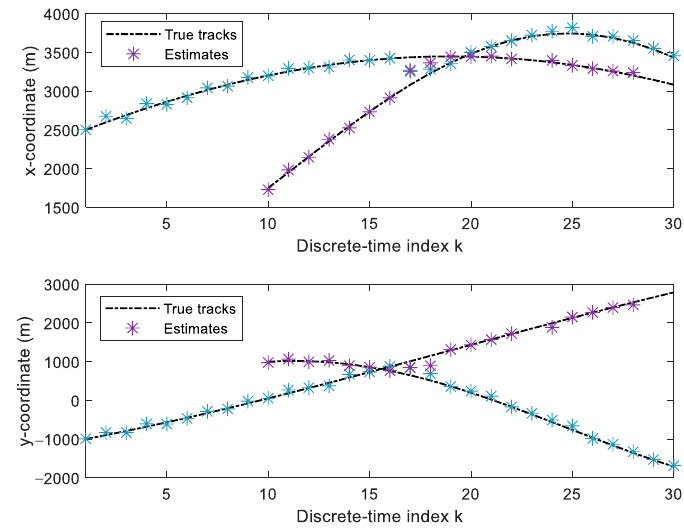
Figure 8. True and estimated tracks versus time in Scenario 1. The average OSPA error (with parameters p = 1 and c = 300 m) and OSPA ( 2 ) error (with the same c , p , and window length w = 10) are given in Figure 9a,b, respectively. The average number of selected sensors is shown in Figure 9c. We observe that both the variance- based approach and the proposed EMOO approach outperform the Cauchy–Schwartz divergence-based approach in terms of OSPA and OSPA ( 2 ) errors. This is mainly because the objective functions of the variance-based approach and the EMOO approach are derived from the cardinality distribution, which is strongly related to the error terms computed